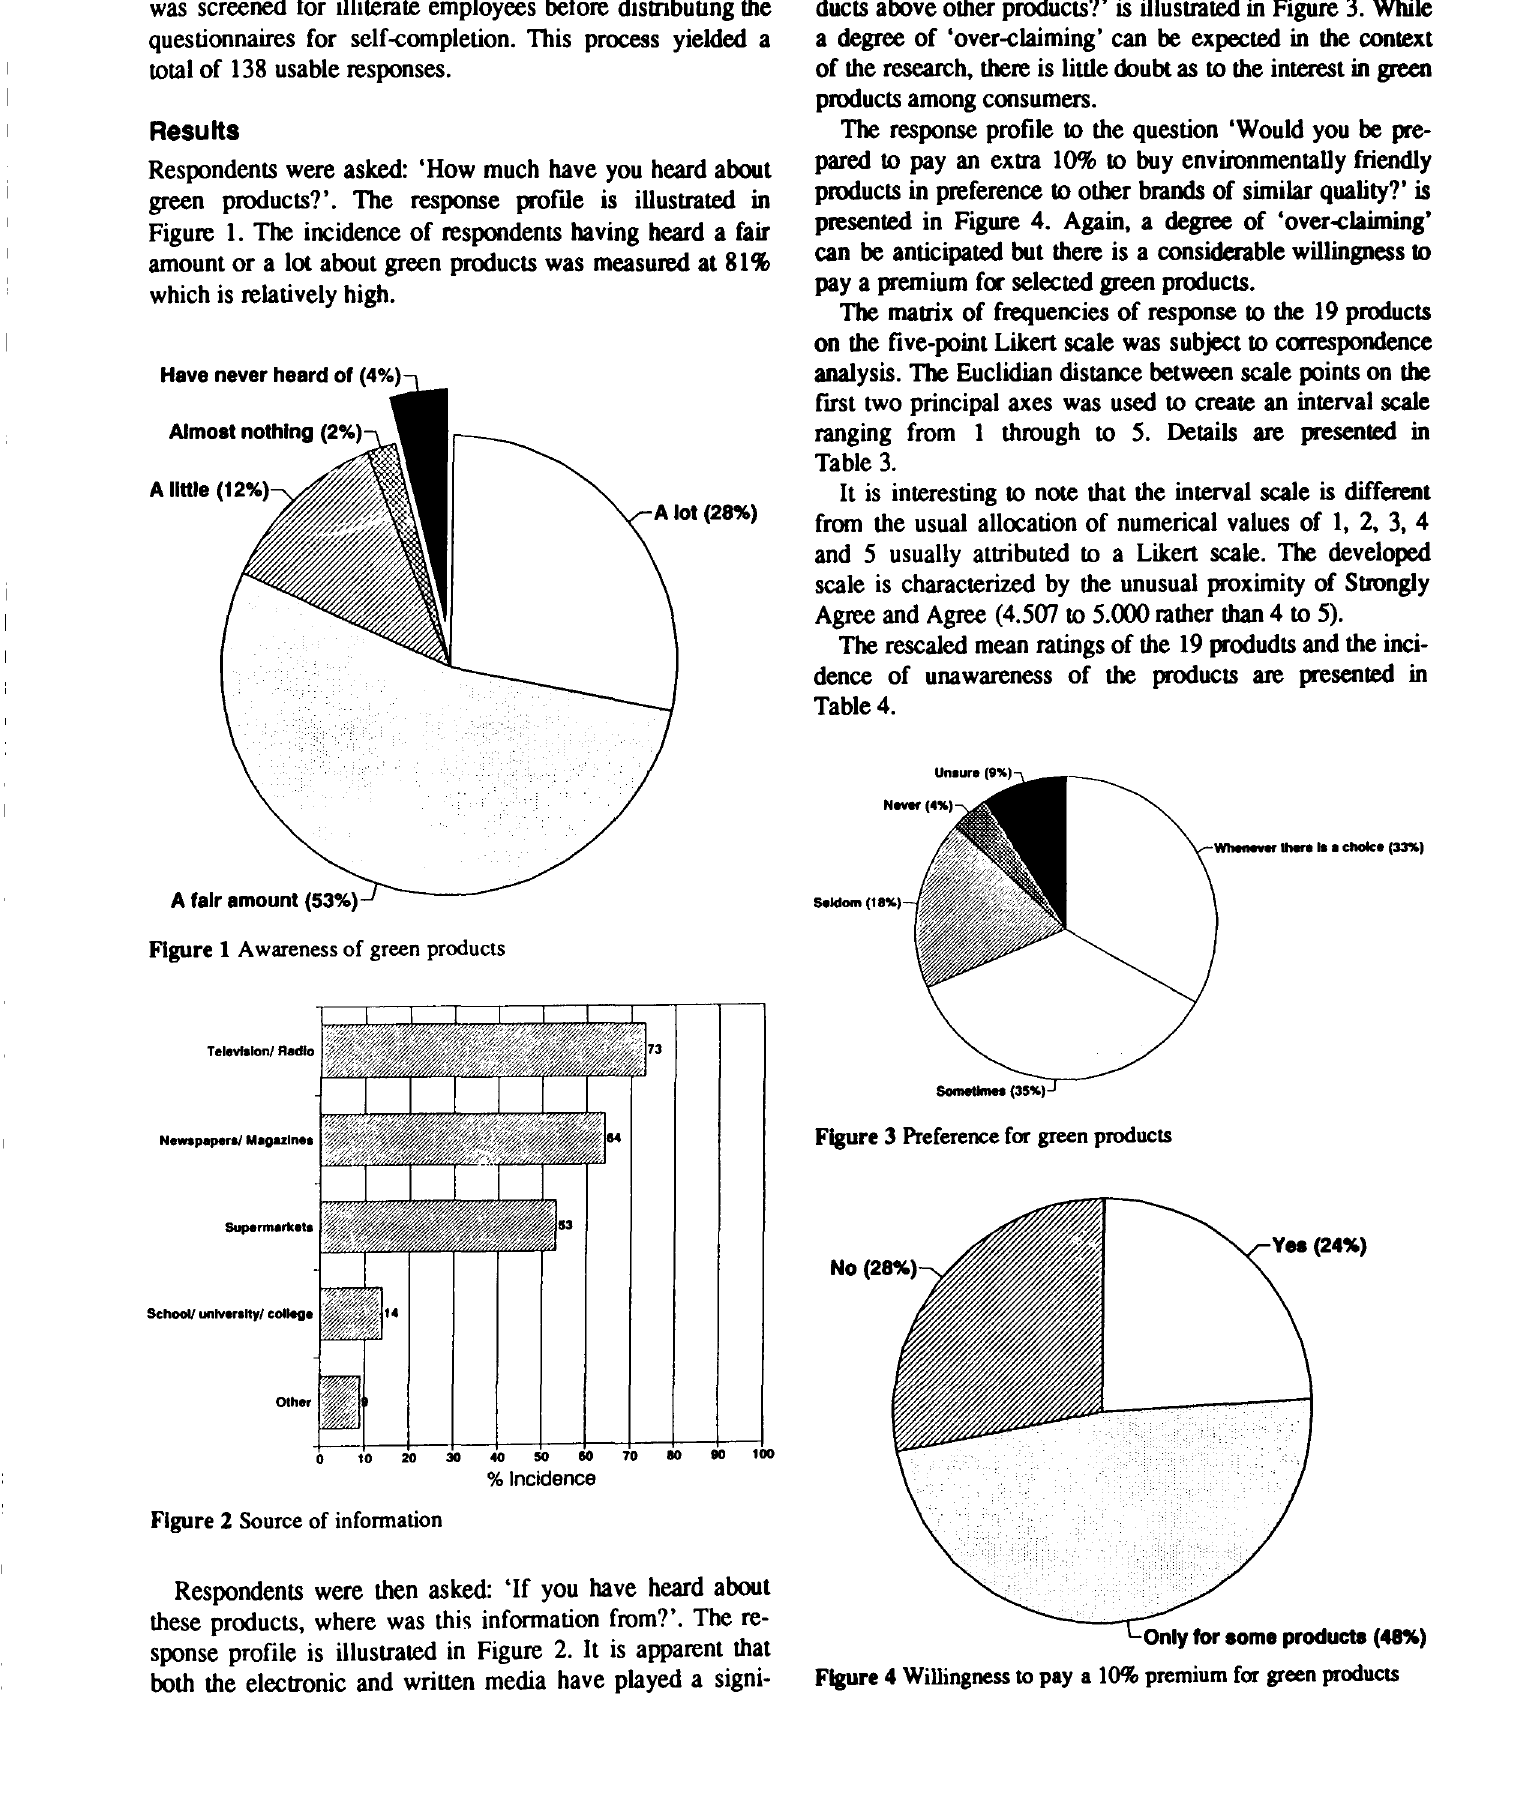
Figure 2 Source of information